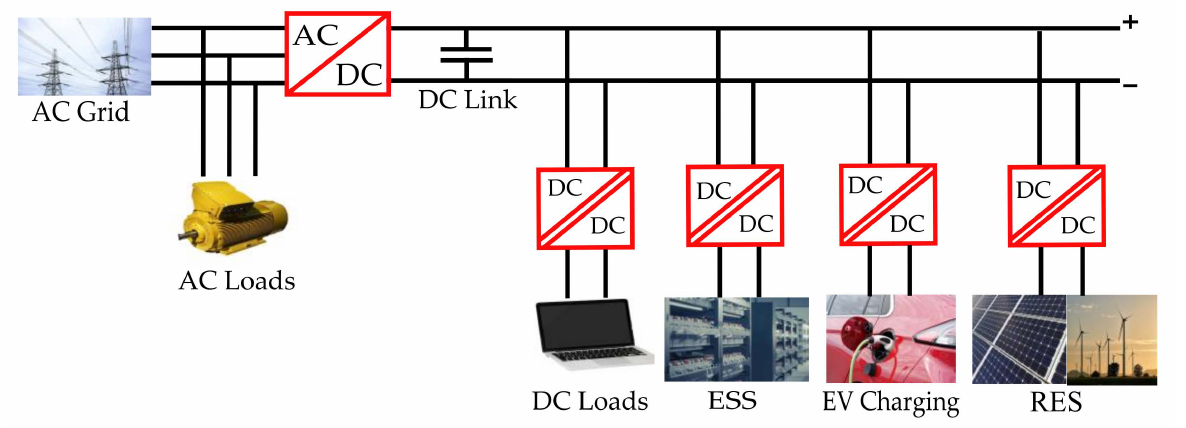
Figure 1. General scheme of an inverter-dominated